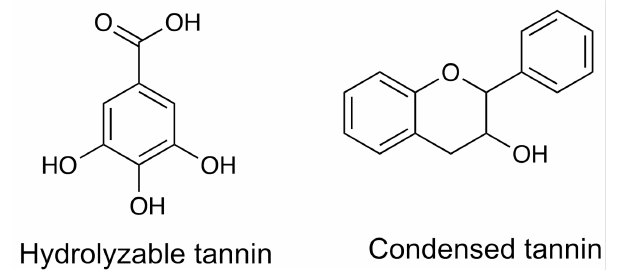
Figure 4. The structures of the main constituents of hydrolyzable tannins and condensed